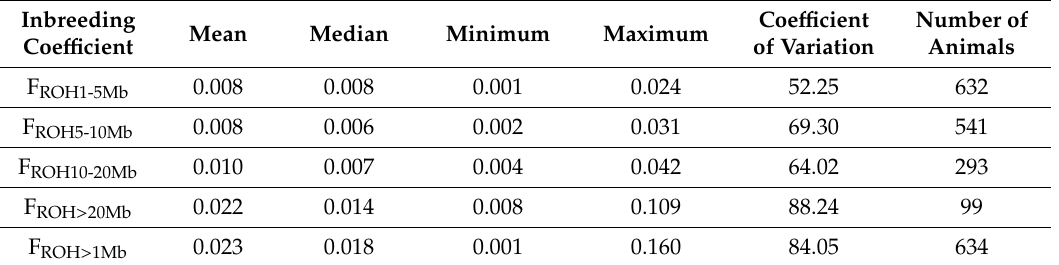
Table 1. The number of genotyped animals and descriptive statistics of runs of